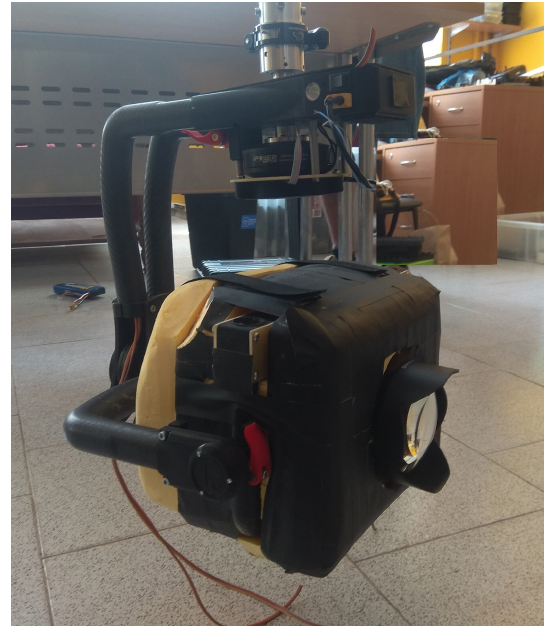
Figure 1. The three-axis motorized gimbal stabilized platform, holding the NLC camera, designed and built by Aerospace labo- ratory “Stratonautica”. Photo by Denis